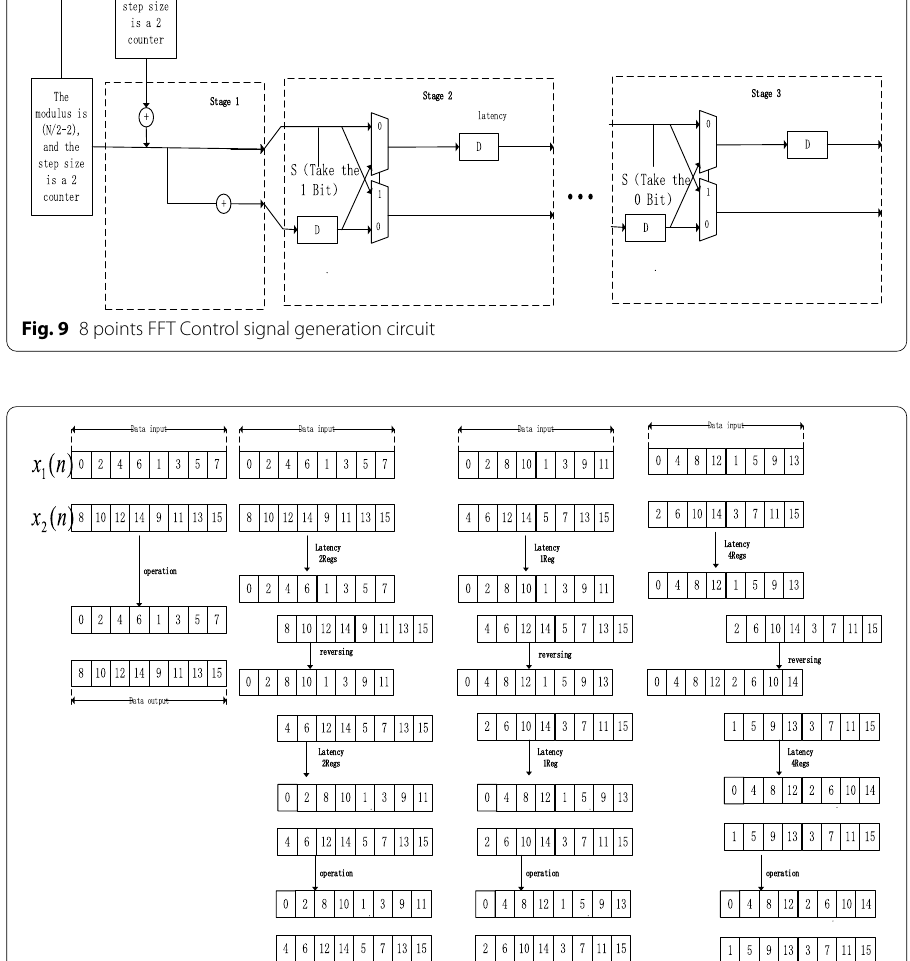
Fig. 10 16 points to improve the MDC architecture data flow